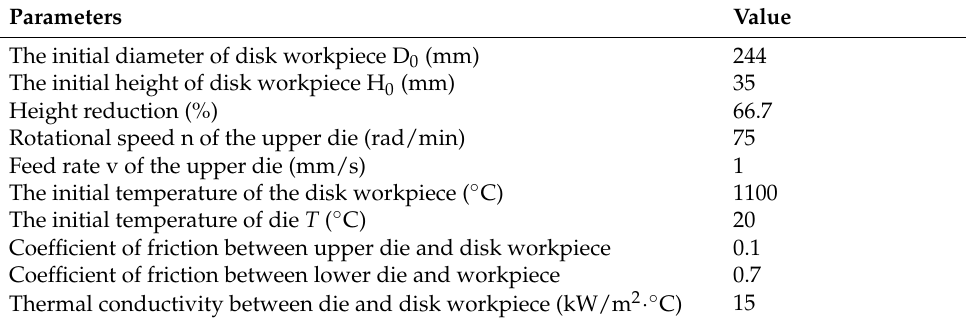
Table 2. Parameters in the numerical simulation process for